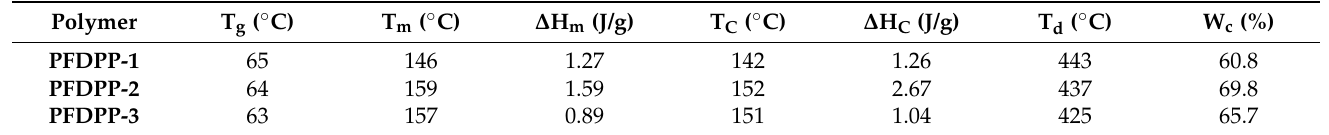
Figure 4. DSC scans of PFDPP polymers heating (H) and cooling (C) at 10 °C/min. Table 2. Summary of thermal properties of PFDPP polymers obtained by DSC and TGA.